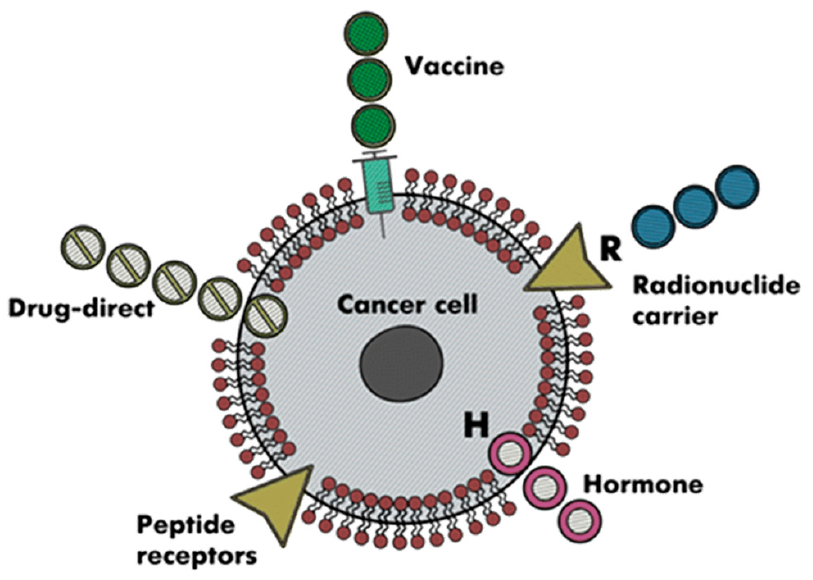
Figure 1. Various possible treatment options for cancer using peptides